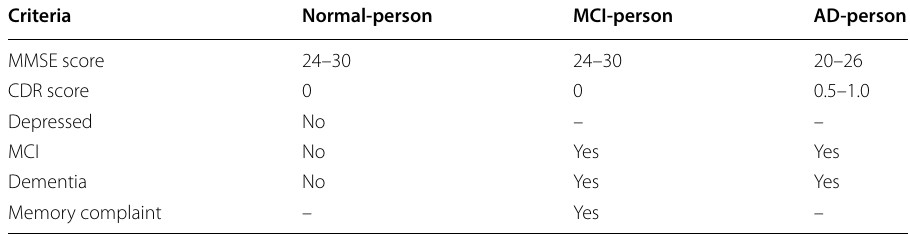
Table 2 Clinical criteria for patients